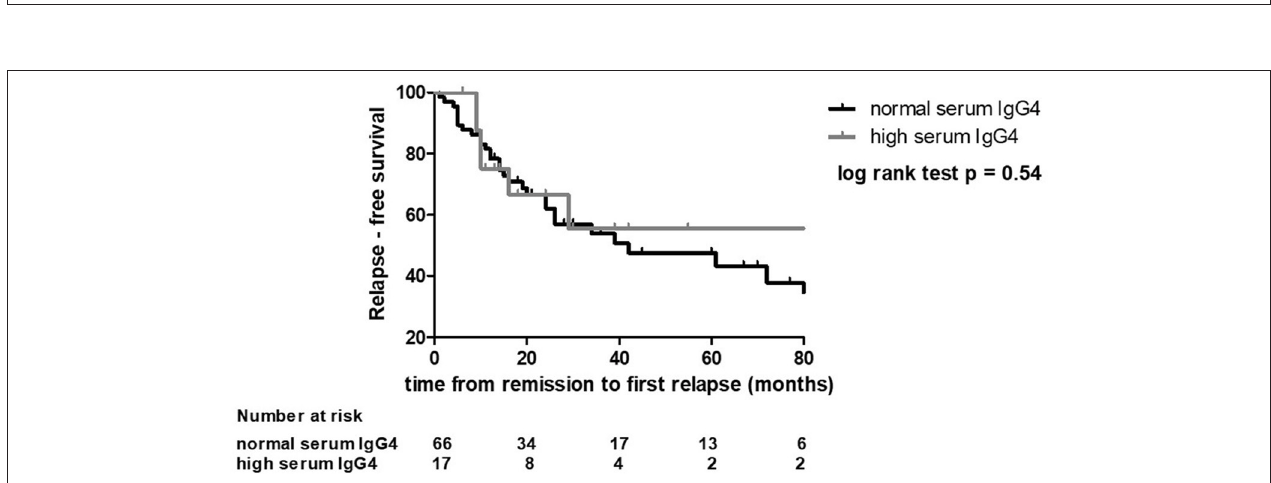
Frontiers in Immunology |